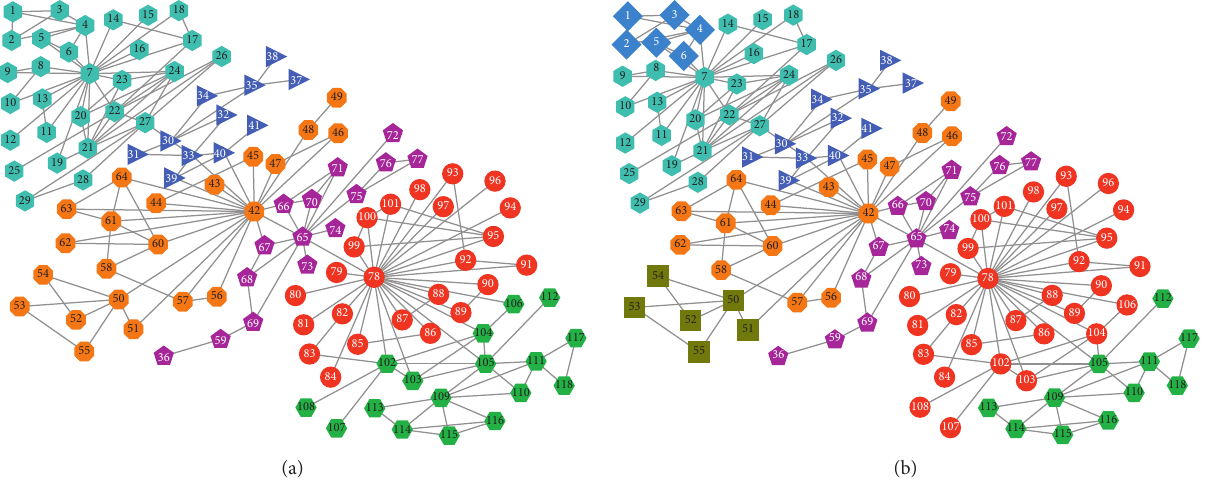
Figure 5: The collaboration network of scientists at the Santa Fe Institute. (a) The ground-truth community structure. (b) The community structure detected by our proposed method.